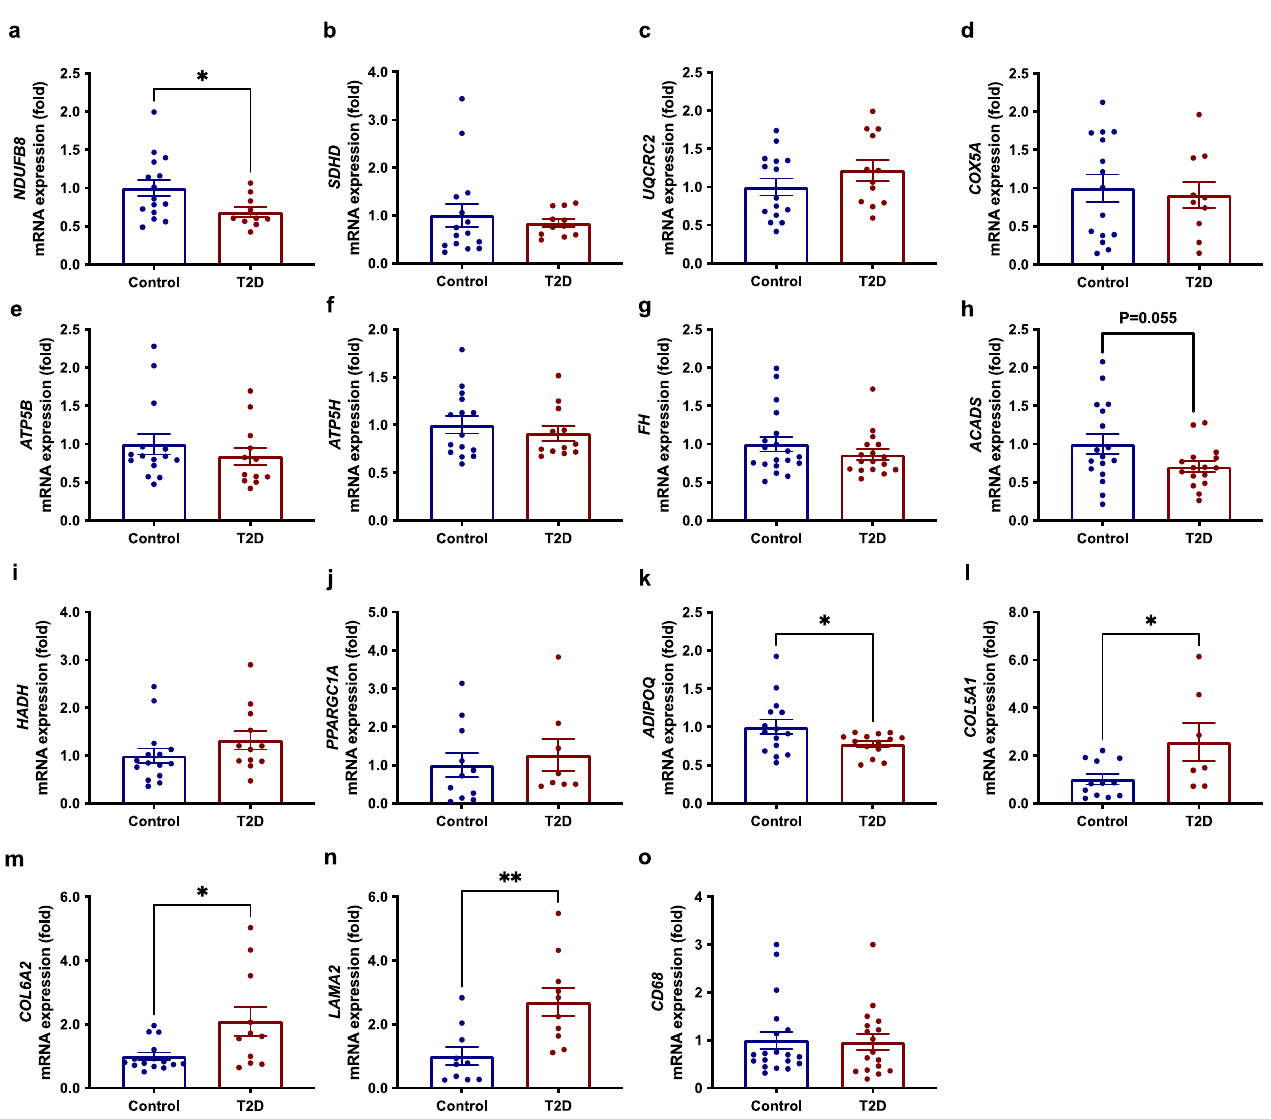
Figure 1. mRNA expression of genes involved in ( a – f ) oxidative phosphorylation ( NDUFB8 , SDHD , UQCRC2 , COX5A , ATP5B, ATP5H ), ( g – i ) the TCA cycle and fatty-acid oxidation ( FH , ACADS, and HADH ), ( j ) transcriptional regulation of mitochondrial biogenesis ( PPARGC1A ) and ( k ) adiponectin ( ADIPOQ ) as well as genes involved in ( l – n ) extracellular matrix ( COL5A1 , COL6A2, LAMA2 ) and ( o ) macrophage infiltration ( CD68 ) in SAT of patients with T2D ( n = 10–17) vs. obese controls ( n = 15–19) determined by qRT-PCR. Data are means ± SEM. * p < 0.05 and ** p < 0.005 vs. obese controls.